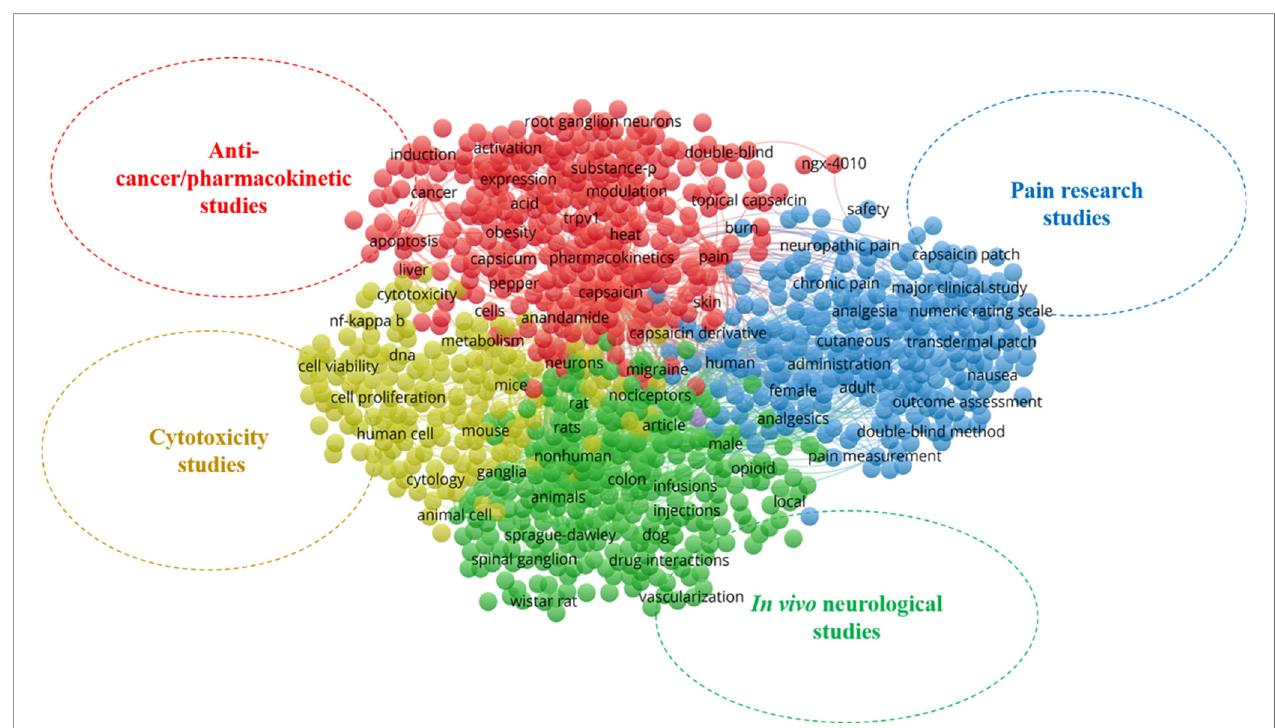
FIGURE 2 | Thematic areas and network visualization of keyword co-occurrence map on capsaicin